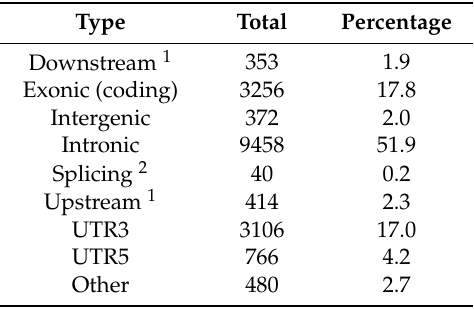
Table 2. Overview of the observed alterations in breast cancer patients by function according to Annovar.